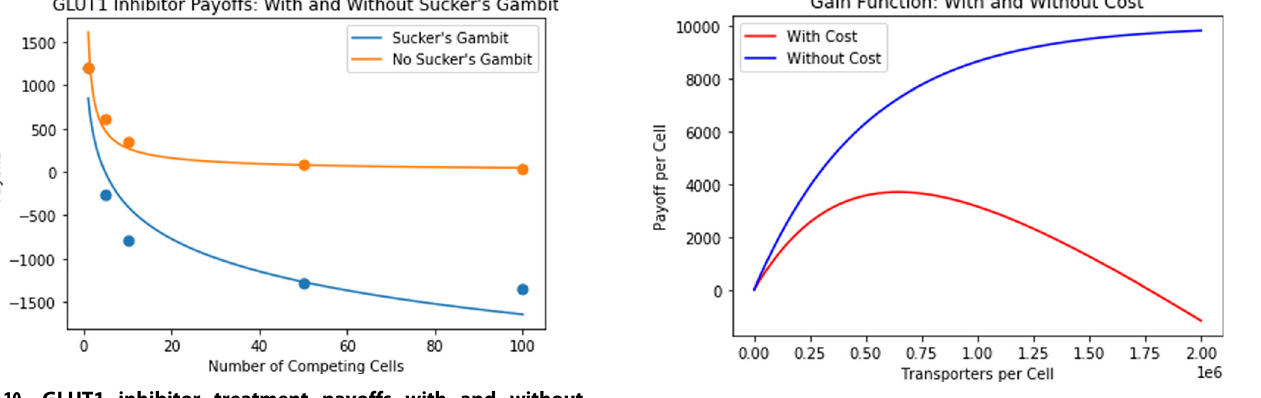
Fig. 11 Plots of nutrient uptake. Incorporation of the cost of transporters into the payoff per cell changes the payoff curve from one which is strictly increasing to one with a clear